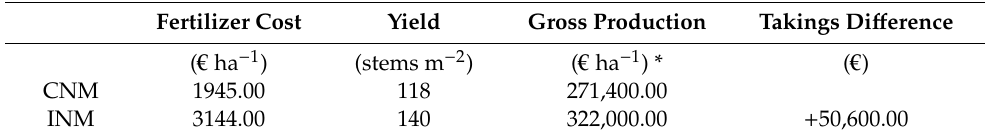
Table 9. Basic economic analysis of fertilizers cost, gross production, and takings di ff erence